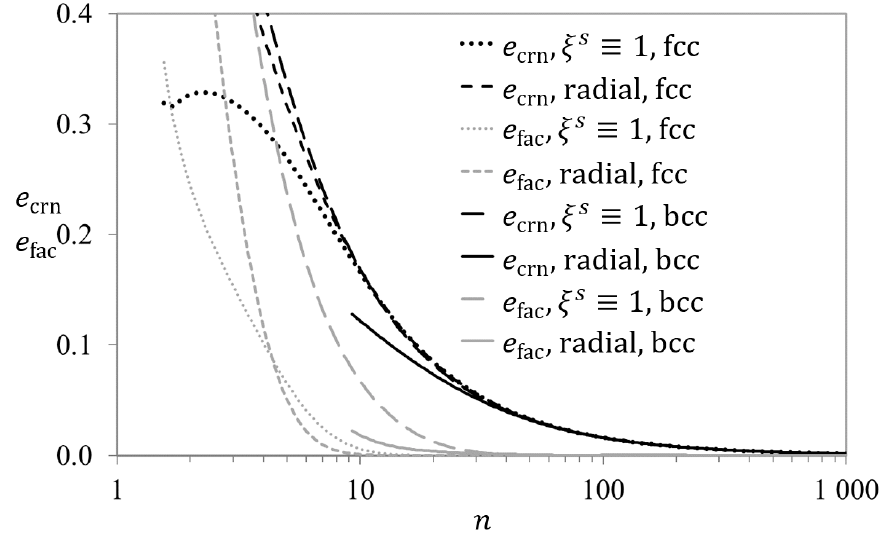
Figure 7. The average error at the corners and at the facet midpoints as a function of n , for the case of bcc with { 110 }(cid:104) 111 (cid:105) and { 211 }(cid:104) 111 (cid:105) slip systems with τ of fcc with basal slips. In both cases, the critical resolved shear stresses are given an additional ±5% randomly chosen variation of their strengths. Yield surface regularizations fitted radially or simply by 𝜉 (cid:3046) ≡ 1 are shown.